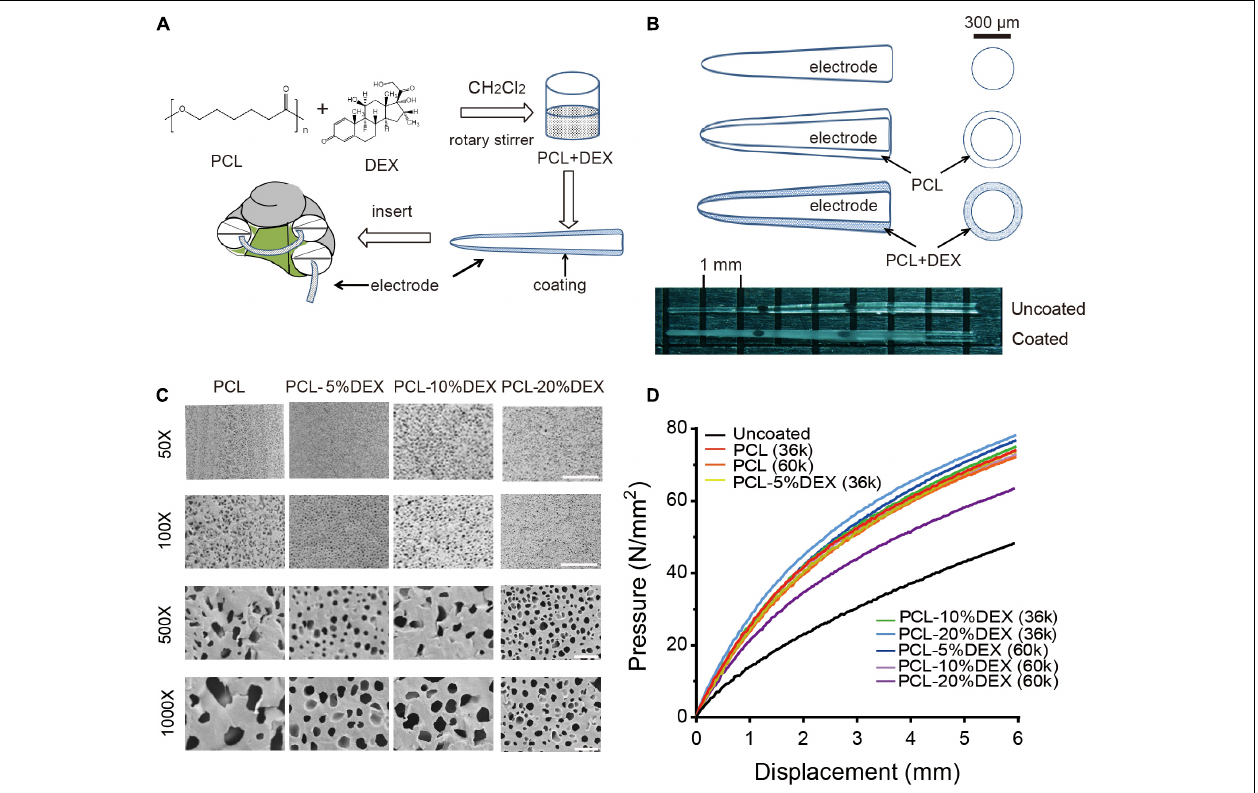
FIGURE 3 | Cochlear implant PCL-coated electrodes and their physical properties. (A) Schematic showing the PCL-DEX coating process of the cochlear implant electrode. (B) Top panels show diagrams of the electrode and its coating. Bottom photographs show the tips of uncoated (pristine) and PCL-DEX-coated electrodes. (C) Scanning electron microscopic images show the surface of electrodes coated with PCL, PCL-5%DEX, PCL-10%DEX, and PCL-20% DEX (MW = 36 k). Scale bar = 100, 20, 10, and 5 µ m for 50 × , 100 × , 500 × , and 1,000 × magnifications, respectively. (D) Color coded lines show the pressure produced by the pristine and coated electrodes at different bend